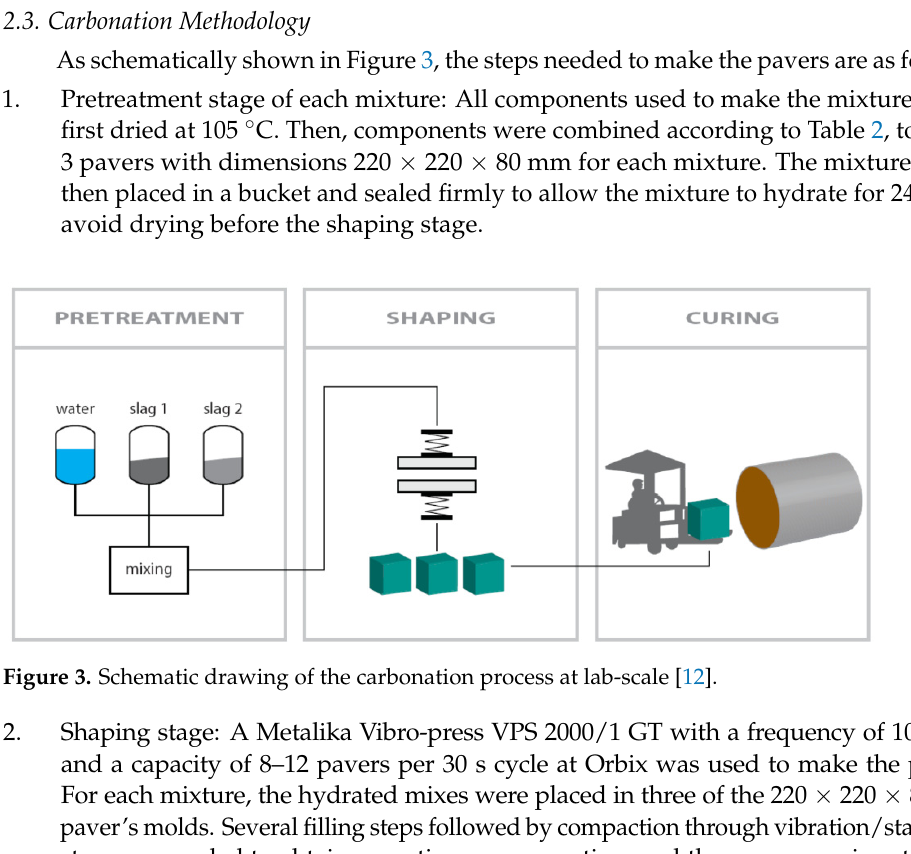
Figure 2. Overall cumulative particle size distribution of mixtures 1 to 8, along with cumulative particle size distribution of the components used in designing of the mixtures.